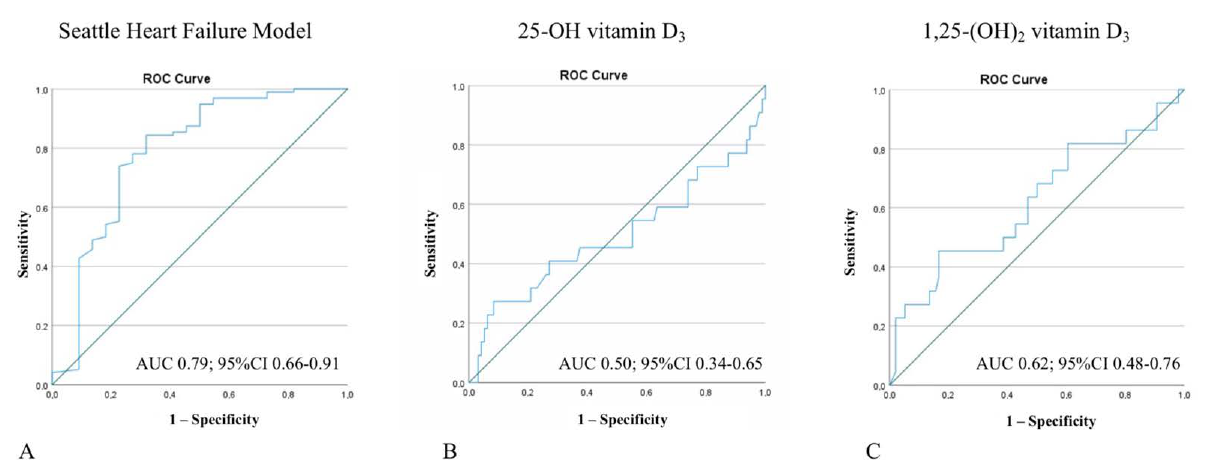
Figure 3. Receiver-operating curves for the SHF model, 25-OH-vitamin D 3 , and 1,25-(OH) 2 -vitamin D 3 . While the SHF model exhibited acceptable discriminatory ability to distinguish between survivors and non-survivors of the one-year follow-up period ( A ), neither 25-OH-vitamin D 3 ( B ) nor 1,25- (OH) 2 -vitamin D 3 ( C ) predicted one-year survival with acceptable